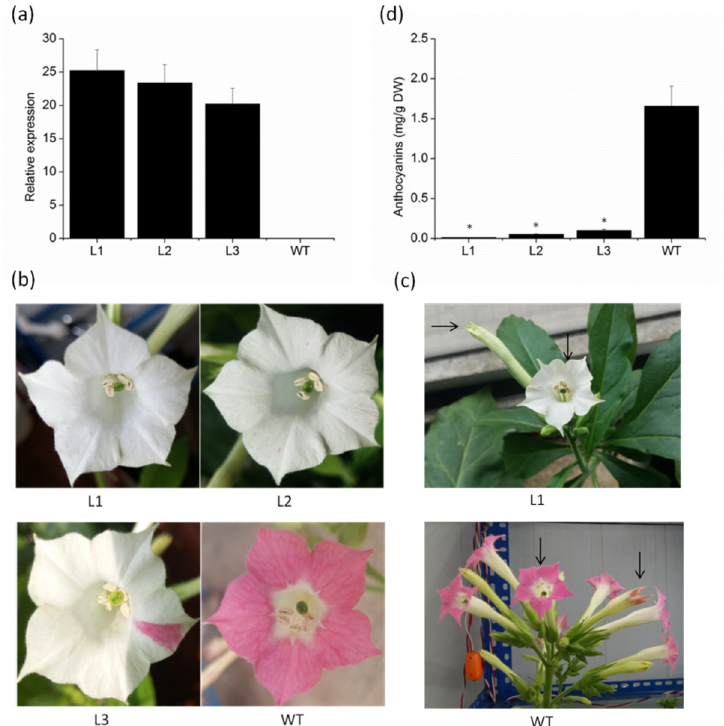
Figure 4. The phenotypes and anthocyanin concentrations of VvMYBC2L2 -overexpressed transgenic tobacco flowers. ( a ) Expression levels of VvMYBC2L2 transcripts in wild-type (WT) and transgenic plants. L1, L2, L3 represent three transgenic tobacco lines. Bars represent mean ± SD. Transcript levels were measured by RT-PCR analysis and the expression data were normalized against the expression of NtActin . ( b ) Typical floral phenotypes of WT and transgenic plants. ( c ) The color of transgenic and WT tobacco flowers at different flower stages. ( d ) The anthocyanin concentrations in WT and transgenic petals. Anthocyanins were extracted with methanol containing 1% ( v / v ) hydrochloric acid, and the absorbance of the solution was measured with a UV-Visible Spectrophotometer. Bars represent mean ± SD. Significant differences from the WT were confirmed by ANOVA and Tukey’s test (* p < 0.05).